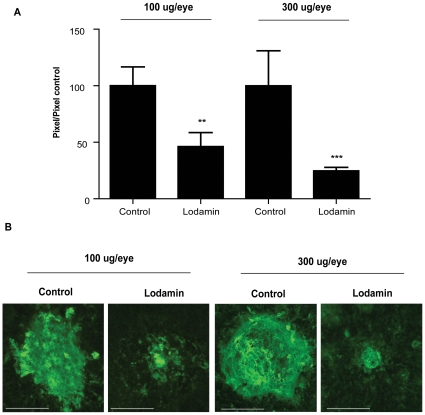
Lodamin injected intravitreal suppresses CNV progression.(A) CNV lesions were induced by a diode pumped solid state laser around the optic nerve through a slit lamp delivery system. Only lesions in which a subretinal bubble or focal serous detachment of the retina developed were used for the experiments. Four burns were performed per eye while leaving a space around the optic disc. At the day of laser induction intravitreal injection of Lodamin was performed. Size of CNV lesions after intravitreal injections of Lodamin: 100 µg Lodamin per eye (12.5 µg TNP-470 equivalent) or 300 µg Lodamin per eye. Data is presented as mean pixel number ± SEM (n = 7–17, *P<0.05, U-test). (B) Representative images of retinal flat-mounts stained with a lectin-FITC, Bars = 10 µm.